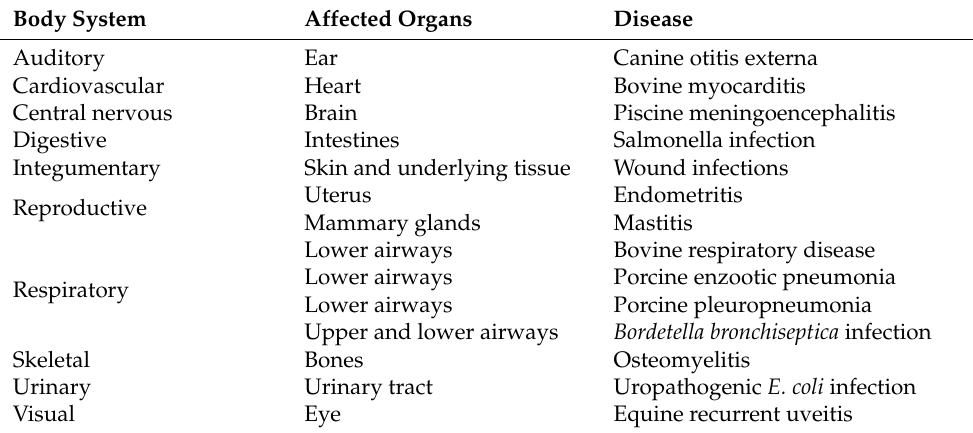
Table 1. Biofilm-associated infections of different body systems and their affected